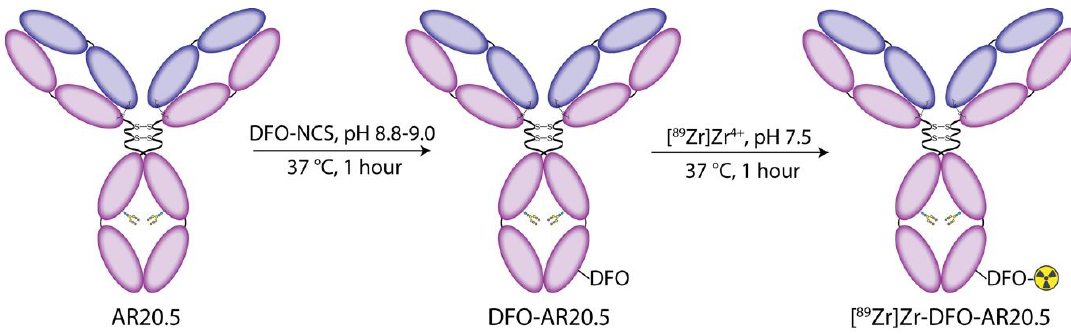
Figure 1. Schematic of the bioconjugation and radiosynthesis of [ 89 Zr]Zr-DFO-AR20.5. 113